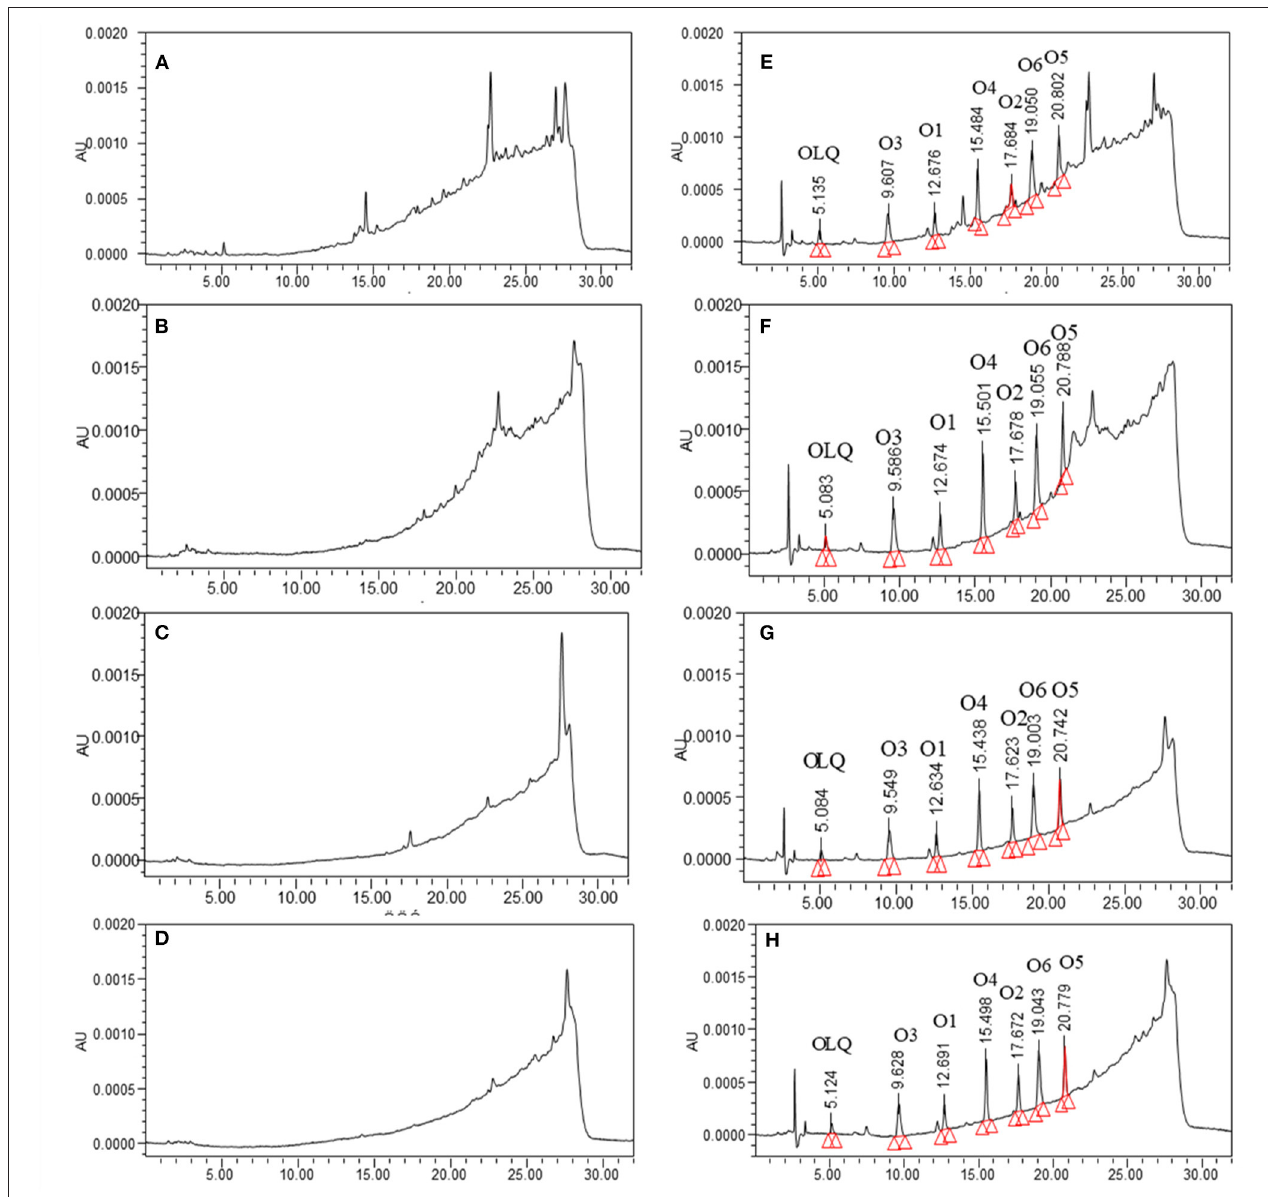
FIGURE 2 | The chromatograms of blank samples from pigs: (A) liver, (B) kidney, (C) muscle, (D) fat, and corresponding blank samples spiked with olaquindox and its main metabolites (40 µ g kg − 1 ): (E) liver, (F) kidney, (G) muscle, (H) fat.